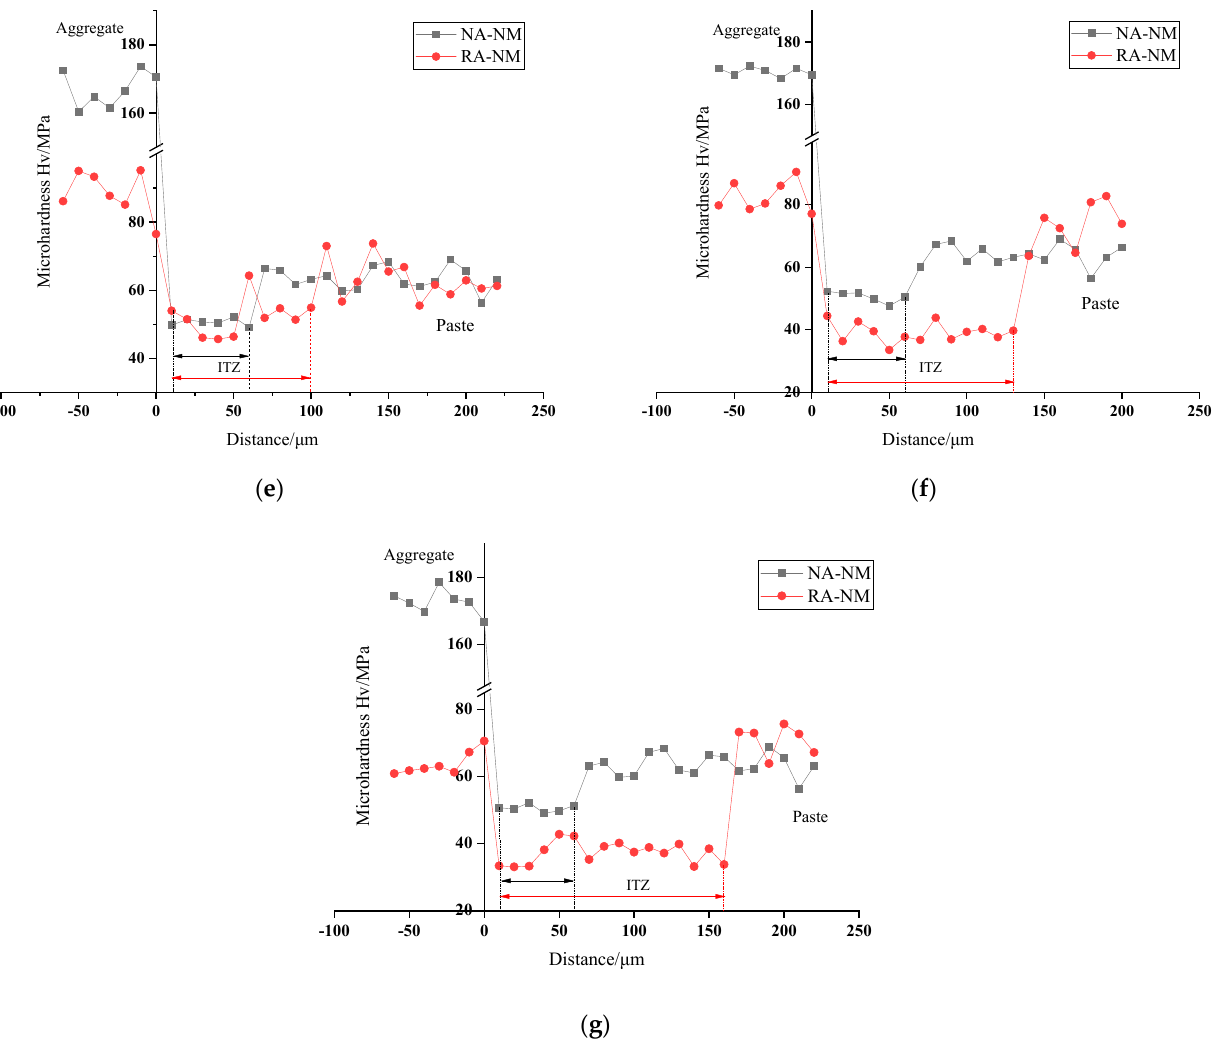
Figure 16. Microhardness of the concrete interfacial transition zone of recycled concrete: ( a ) AD; ( b ) W50; ( c ) W55; ( d ) W60; ( e ) W65; ( f ) W75; ( g ) W100. Table 4. The variation range of 28 d microhardness in the interfacial transition zone of recycled